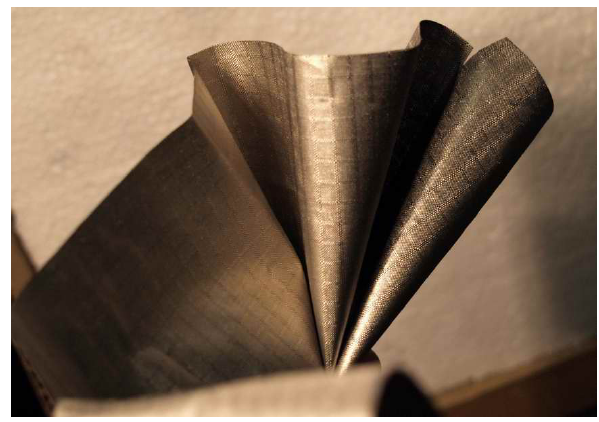
Figure 4. Nora Dell conductive